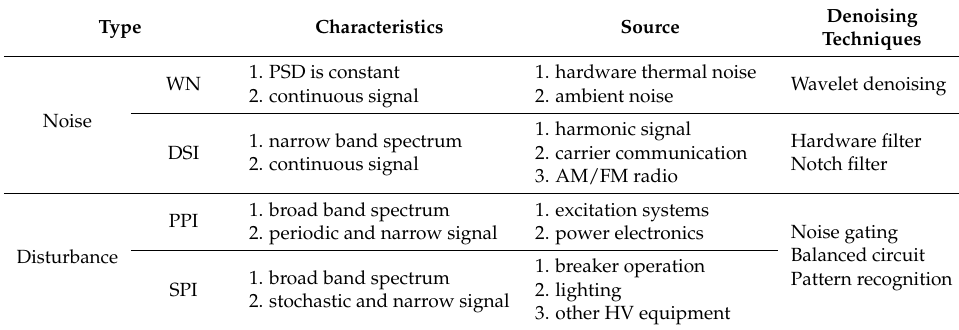
Table 5. Comparison of different noise and disturbance [9,32,66,80,85].